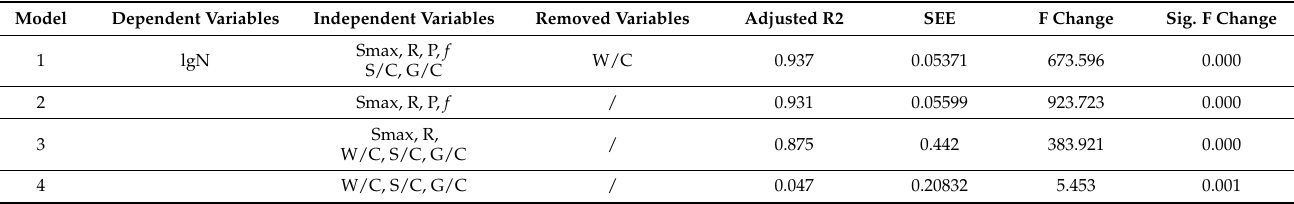
Table 6. Summary of analysis results from MLR